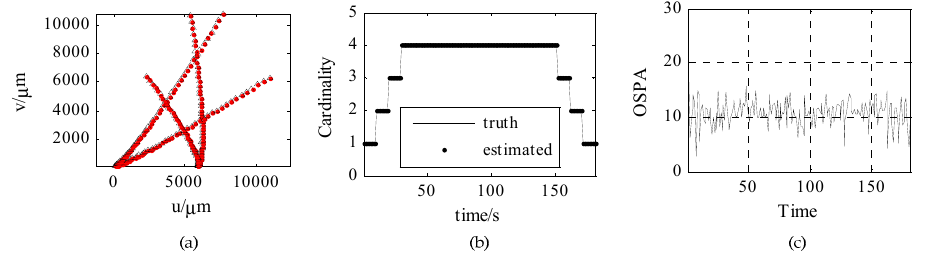
Figure 11. Trajectory tracking, cardinality estimated, and OSPA based on ambiguous measurement. ( a ) is trajectory tracking, ( b ) is cardinality estimated, ( c ) is OSPA.